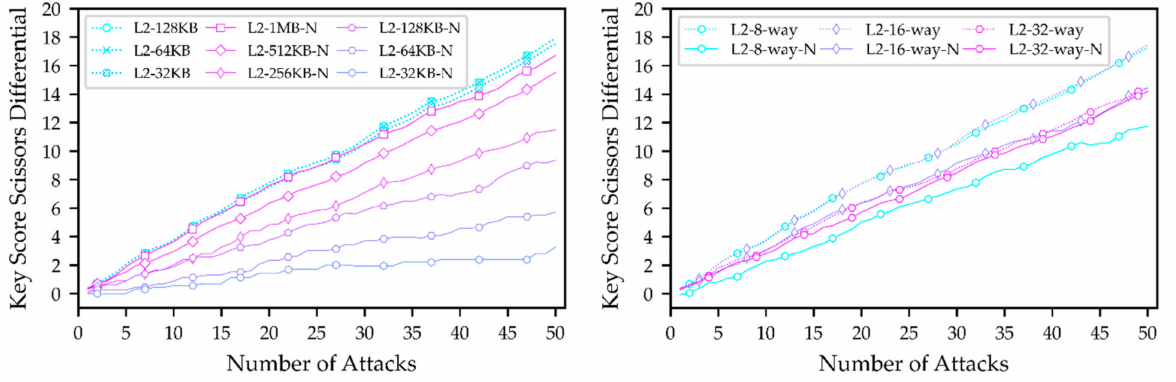
Figure 6. Evaluation of shared cache capacity ( left ) and shared cache associativity ( right